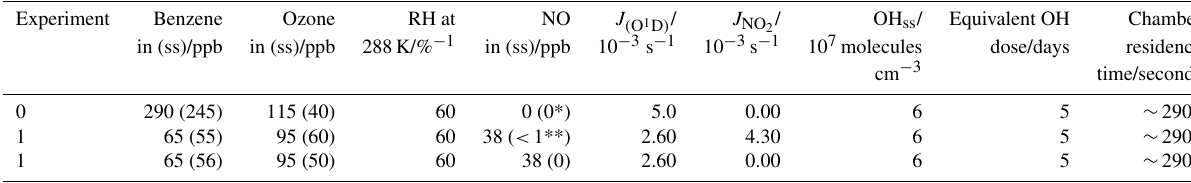
Table 1. Summary of selected experiments performed at JPAC used in this study. Two photolysis states are reported for the NO x -containing studies. The first describes steady-state concentrations with J NO light on. OH equivalent dose is based on 10 6 OHmoleculescm − 3 . * NO 2 , background from VOC catalyser. ** not measured, estimated from experiment with similar NO x addition, O 3 and